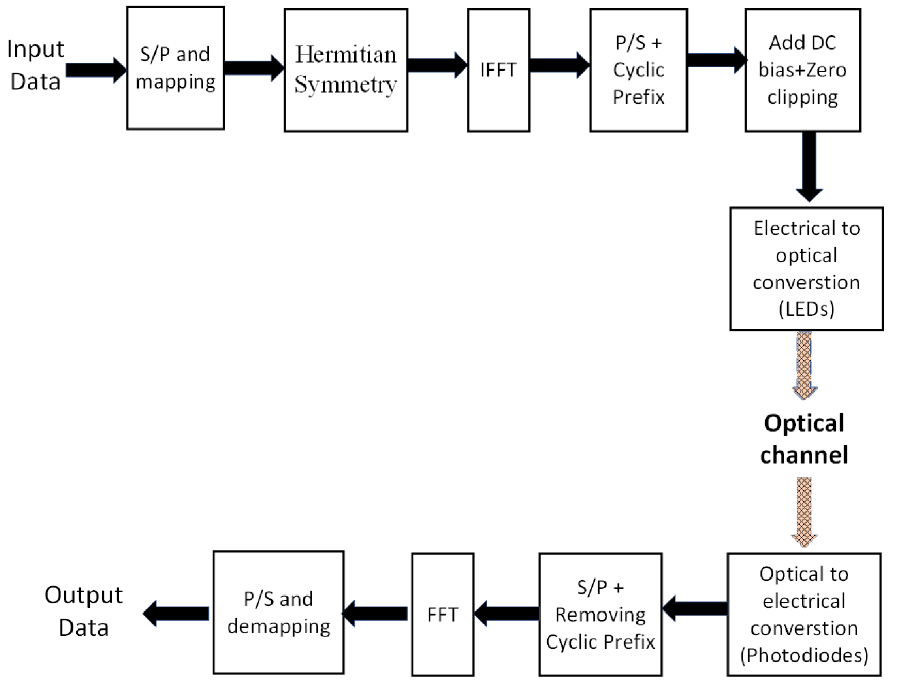
Fig 1. Block diagram of a DCO-OFDM based LiFi